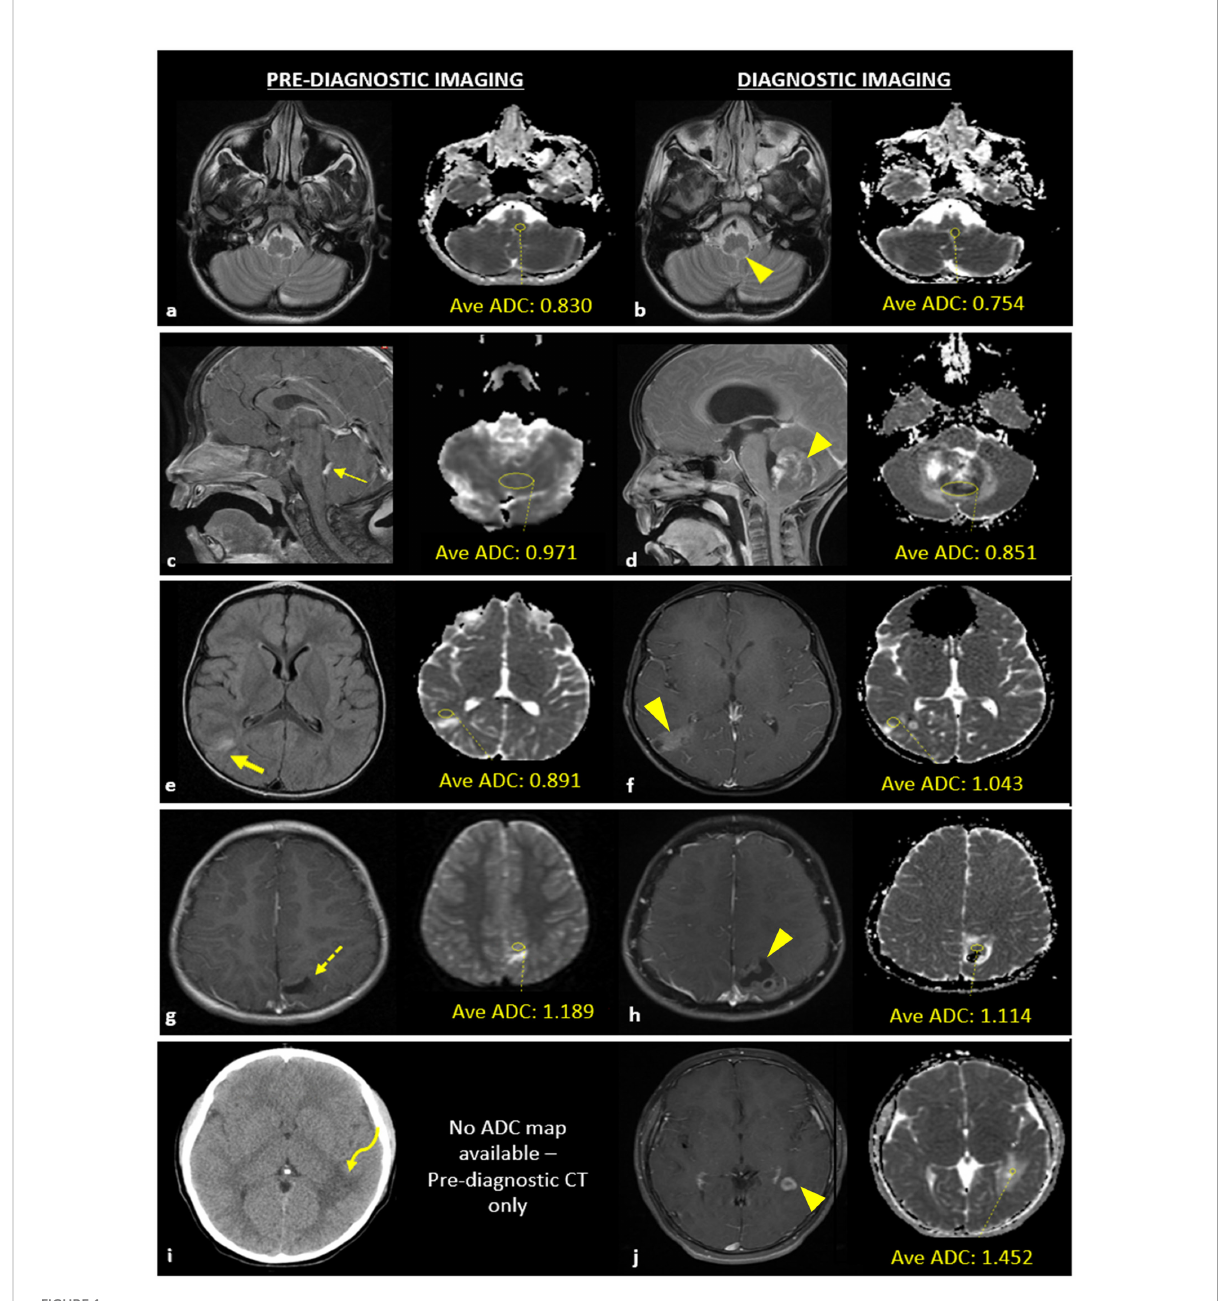
FIGURE 1 Example of apparent diffusion coef fi cient (ADC) acquisition for a patient with a case of central nervous system lymphoma (A, B) and examples of neuroimaging studies with abnormal fi ndings at the site of pediatric brain tumor development (C – J) . (A) T 2 -W MRI sequence of pre-diagnostic neuroimaging without a macroscopic tumor present and corresponding ADC map with a yellow circle that delineates the area used to calculate average ADC value of the tissue region in which a brain tumor would later develop; (B) T 2 -W MRI sequence obtained at the time of diagnosis demonstrating the macroscopic lesion (arrowhead) and corresponding ADC map with a yellow circle that delineates the area of the tumor used to calculate average ADC value. (C) Pre-diagnostic contrast enhanced (CE) -T 1 WI sagittal image showing thickened, enhancing choroid (thin arrow) and pre-diagnostic ADC map; (D) post-diagnostic CE-T 1 WI sagittal image and ADC map of atypical teratoid rhabdoid tumor (ATRT). (E) Pre-diagnostic T 2 / FLAIR-WI axial image showing hyperintense T 2 /FLAIR signal (thick arrow) and pre-diagnostic ADC map; (F) post-diagnostic CE -T 1 WI axial image with ADC map of low-grade glioma. (G) Pre-diagnostic CE -T 1 WI axial image showing encephalomalacia/gliosis (dashed arrow) and pre-diagnostic ADC map; (H) post-diagnostic CE -T 1 WI axial image with ADC map of a ganglioglioma. (I) Pre-diagnostic axial CT image showing white matter hypoattenuation (curved arrow); no pre-diagnostic ADC map was available due to lack of MR imaging; (J) post-diagnostic CE-T 1 WI axial image with ADC map of